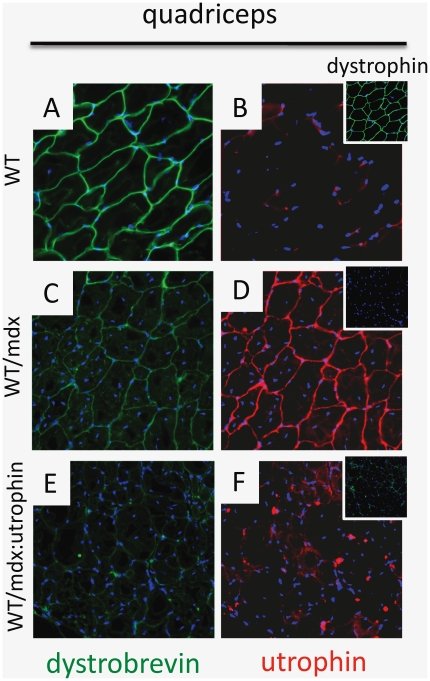
Utrophin sustains weak dystrobrevin staining.Dystrobrevin (A) is detected in WT quadriceps muscle; weak dystrobrevin (C) and utrophin (D) are detected in WT/mdx quadriceps muscle areas with undetectable dystrophin (D inset); no dystrobrevin (E) and no utrophin (F) are detected in WT/mdx∶utrophin quadriceps muscle areas with undetectable dystrophin (F inset); Abbreviation: utr: utrophin; blue: nuclear staining (DAPI); magnification: 200×.